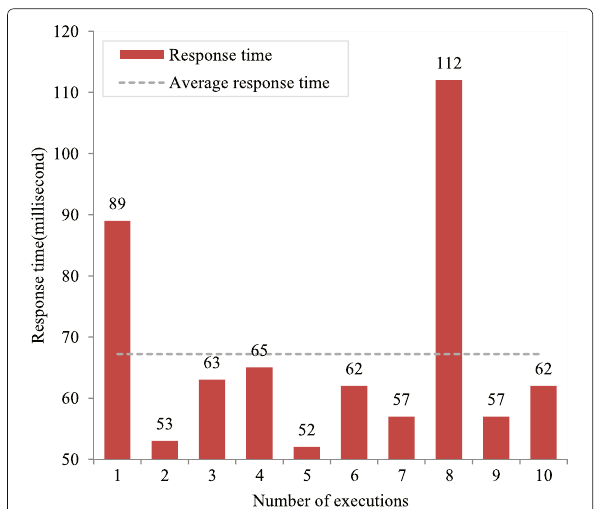
Fig. 10 Service performance of MGP grid data